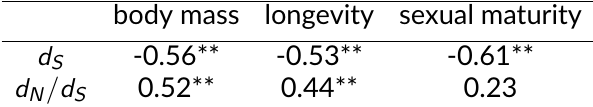
Table 1 – Relationships between life-history traits and molecular substitution rates